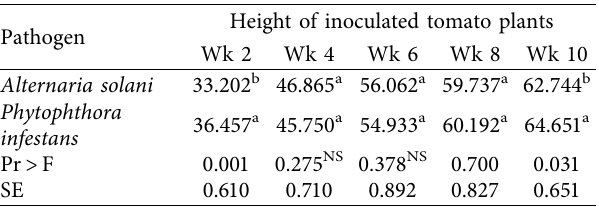
Table 6: Effect of the test pathogens on plant height.